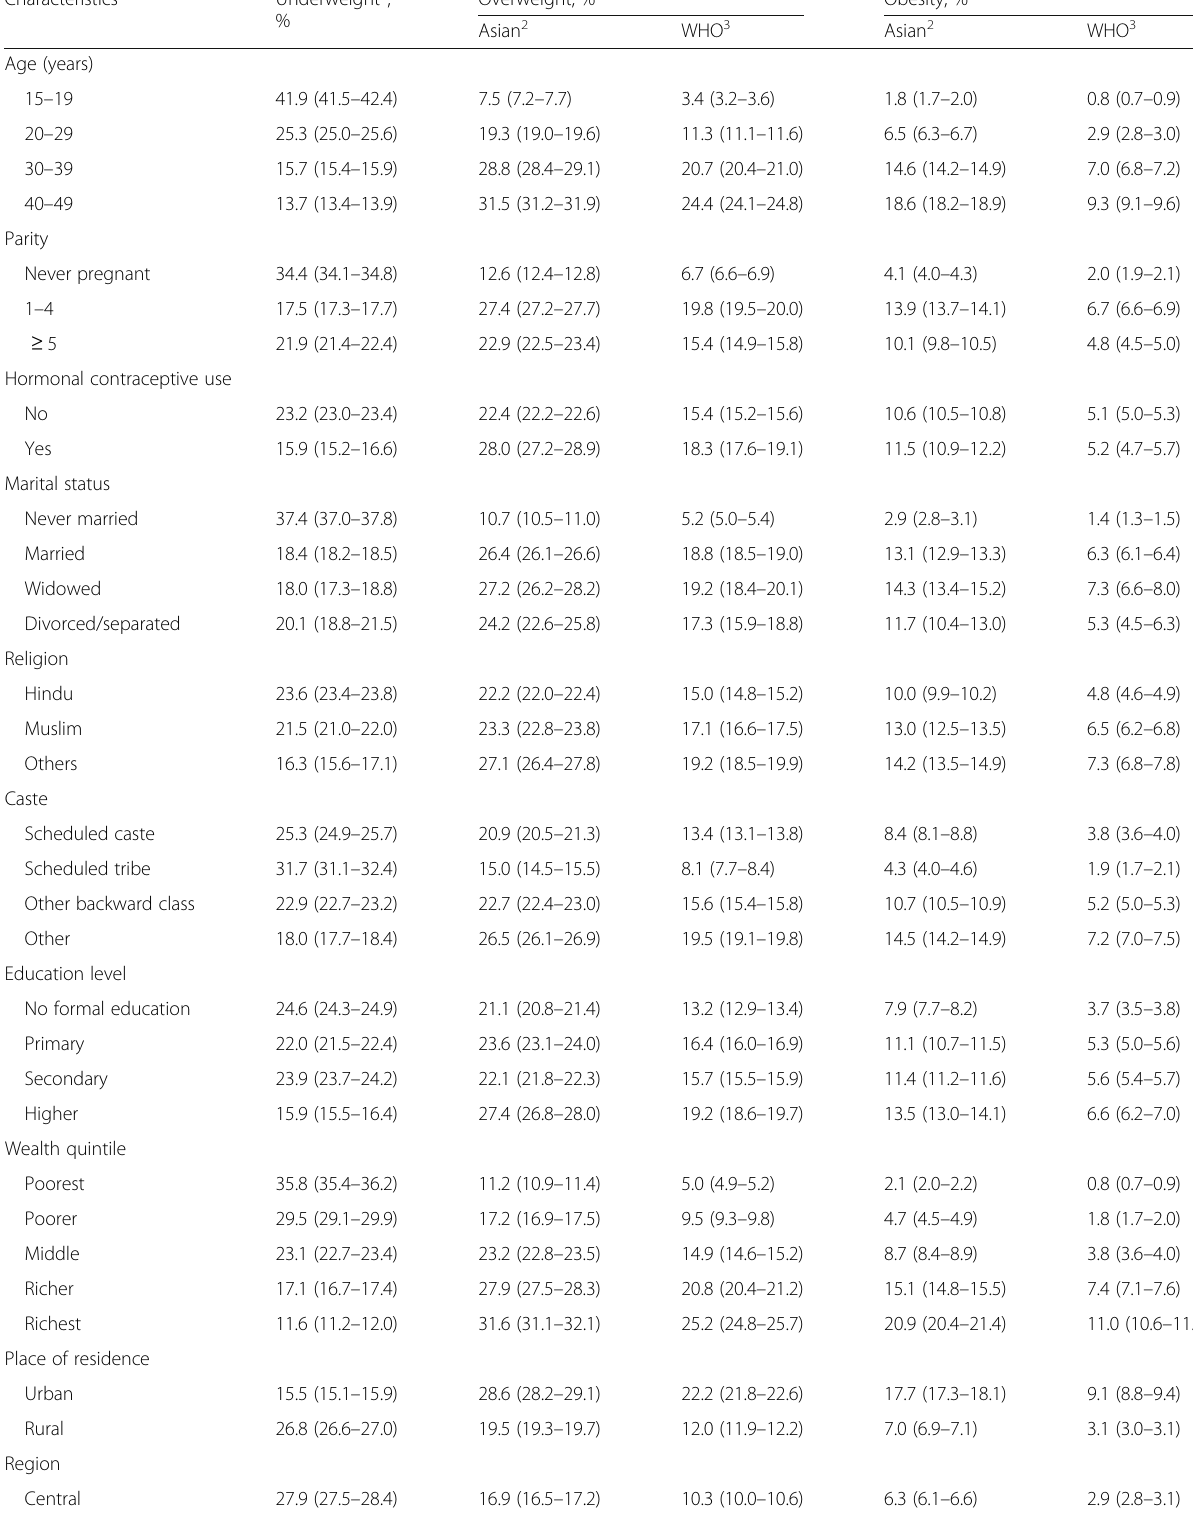
Table 2 Prevalence (with 95% CI) of underweight, overweight and obesity according to BMI categorization among women of reproductive age in